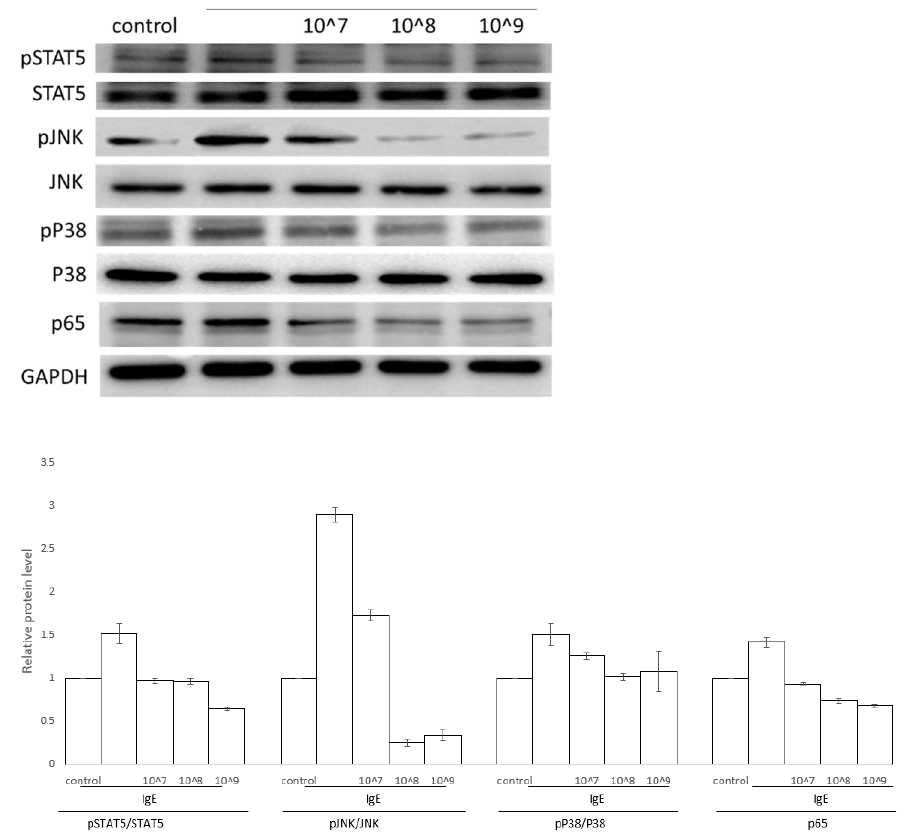
Figure 4. Functional mechanisms of UCMSC-EVs on DNP-IgE-activated KU812 cells. Representative Western blots of p-STAT5, p-p38, p-JNK, and p65 expression in KU812 cells treated with DNP-IgE or plus different concentrations of UCMSC-EVs. The relative fold change in phosphorylated protein to total protein levels was obtained from 3 individual datasets.